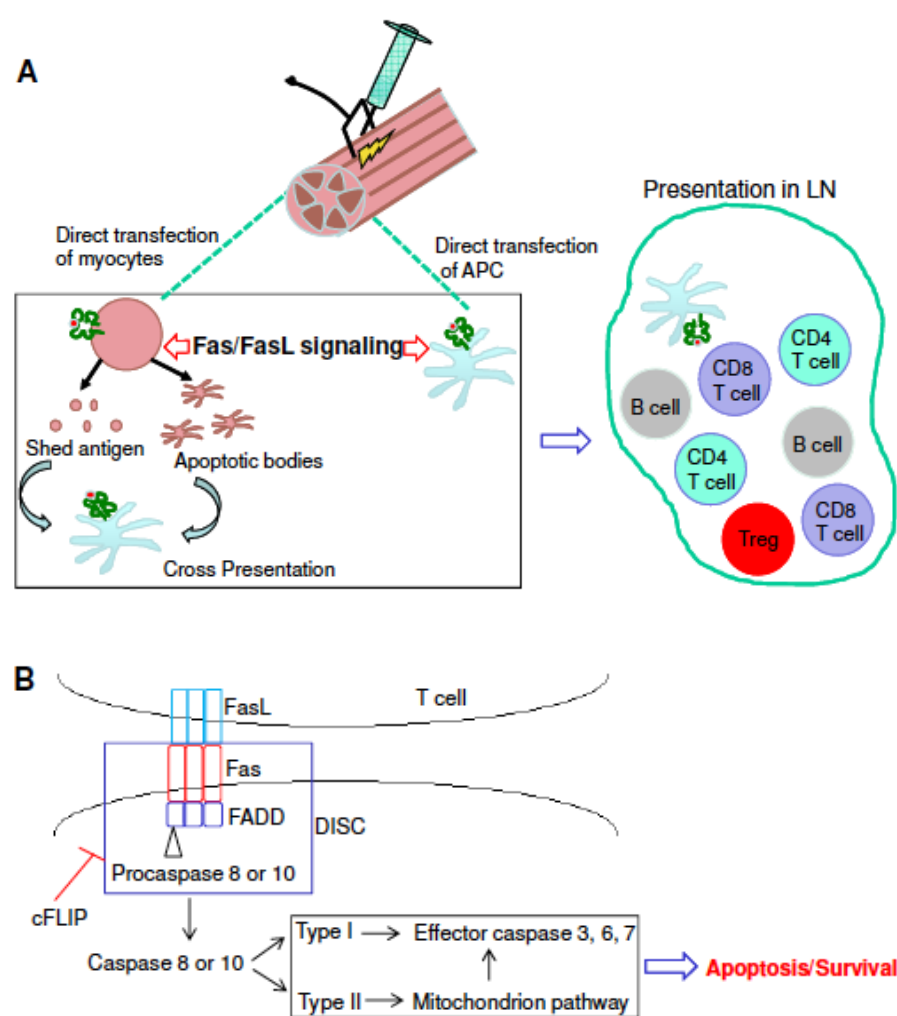
Figure 9. The fate of plasmids and their expressed antigens after electroporation ( A ); The Fas/FasL signaling pathway and some of the key molecules involved ( B